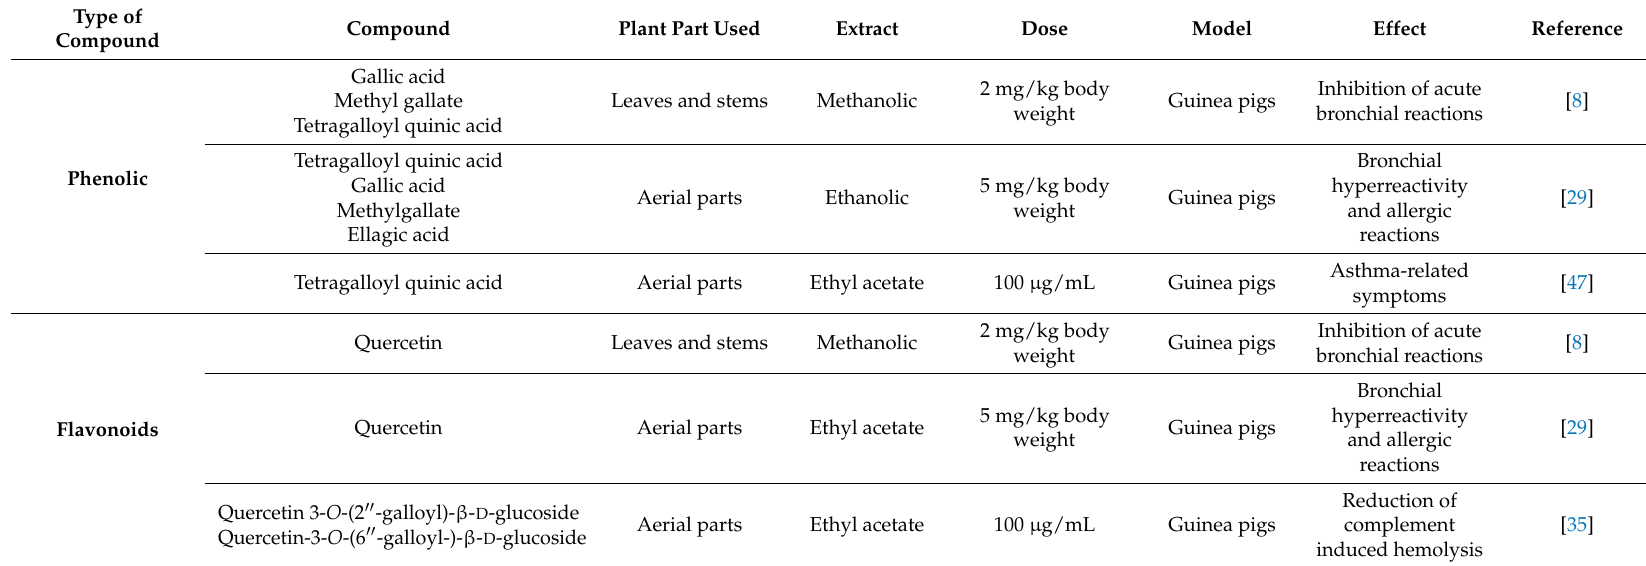
Table 1. Phytochemical compounds with beneficial health effects found in Galphimia